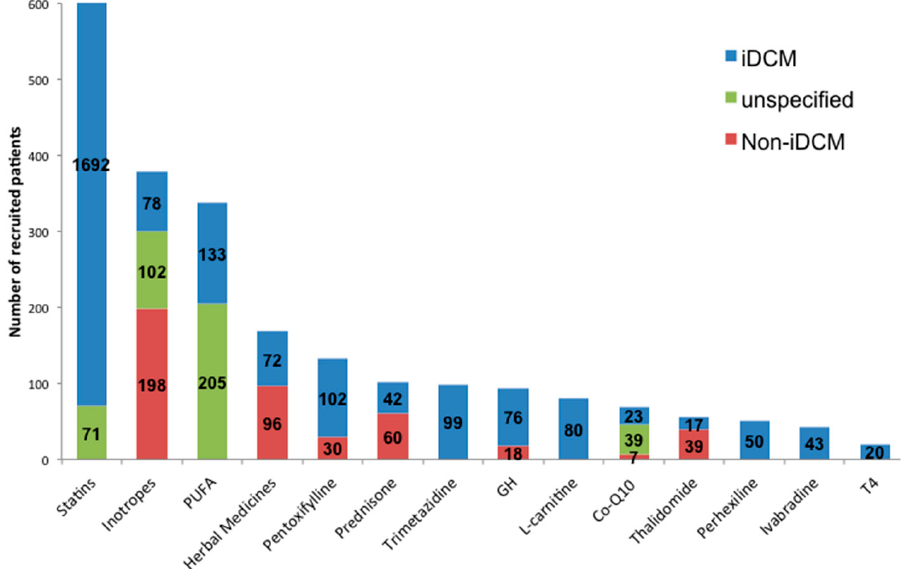
Figure 2. Bar graph showing the total number of recruited patients per drug class. Of note, the unspecified and non-iDCM groups represent heterogeneous population composed of ischemic, valvular, hypertensive, peripartum, post viral myocarditis cardiomyopathy, and an undisclosed number of iDCM subjects.